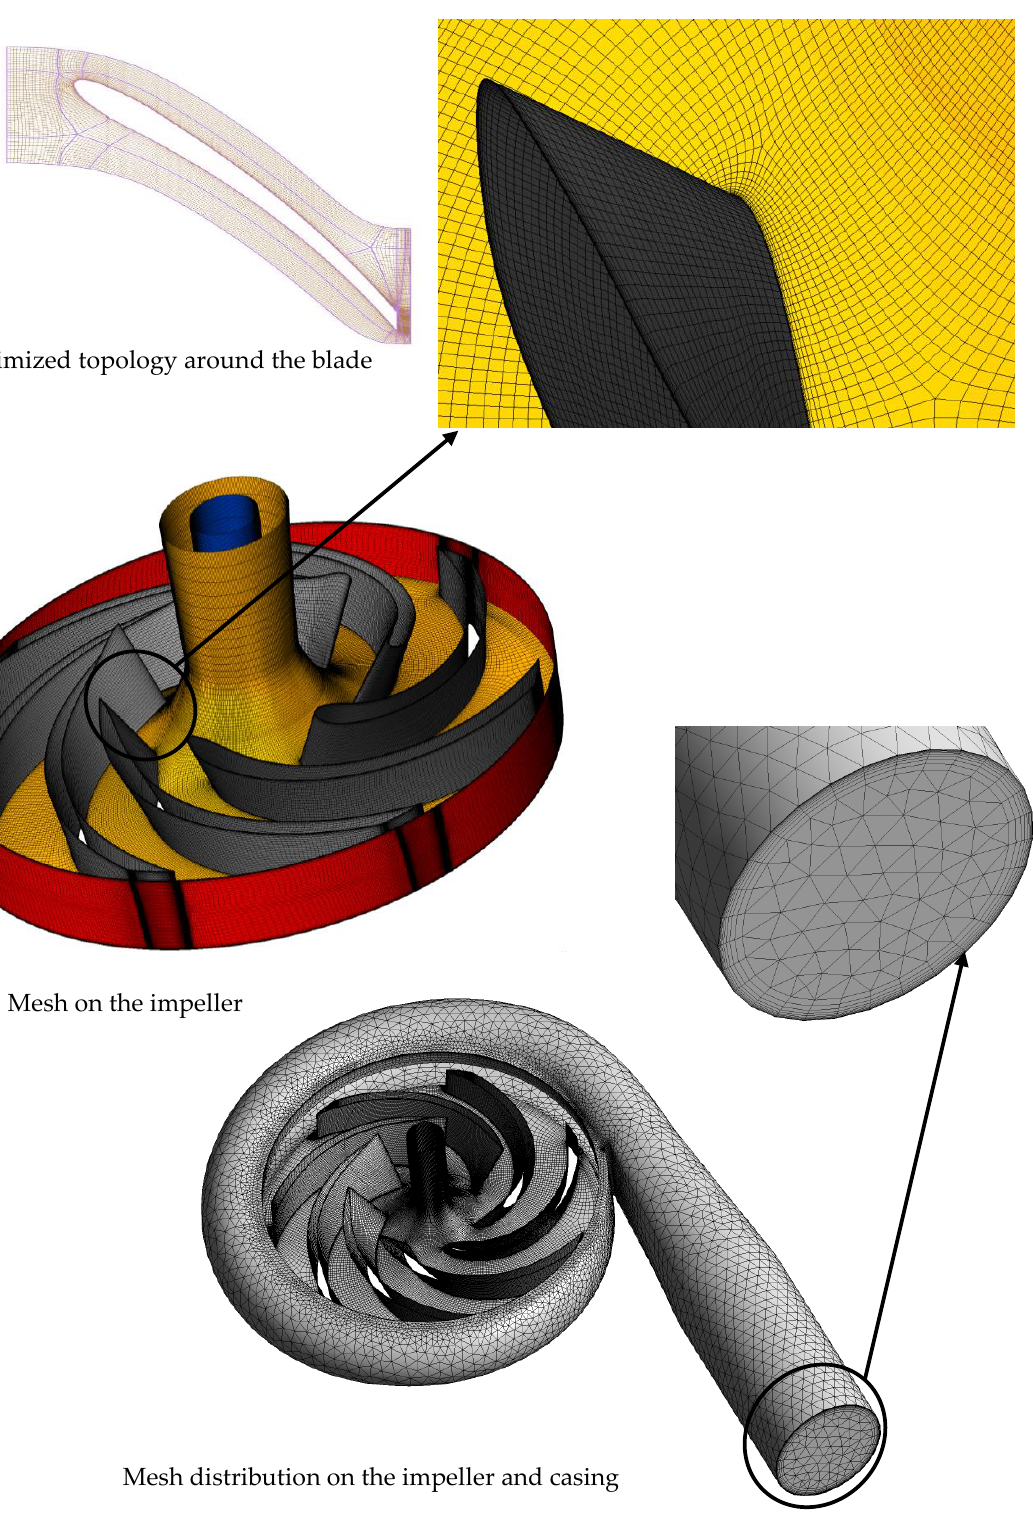
Figure 7. Mesh for the impeller and volute casing.